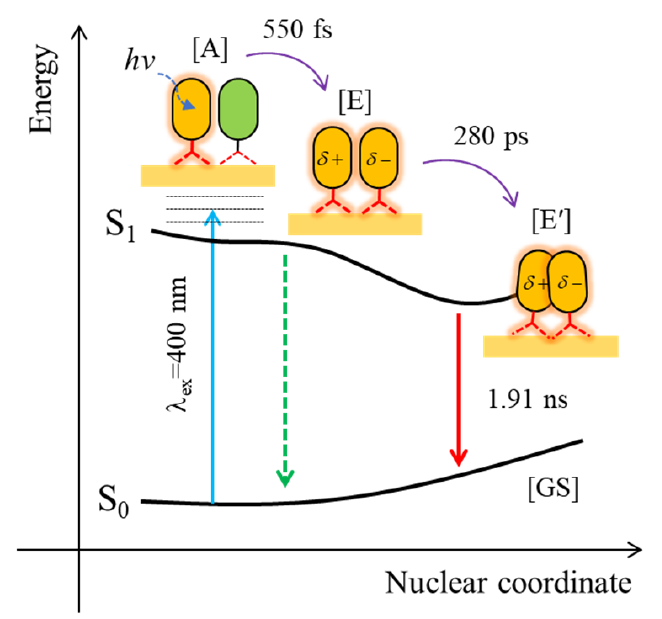
Figure 8. Proposed reaction pathways of Al 2 O 3 :OHCCA agg film in the excited state.